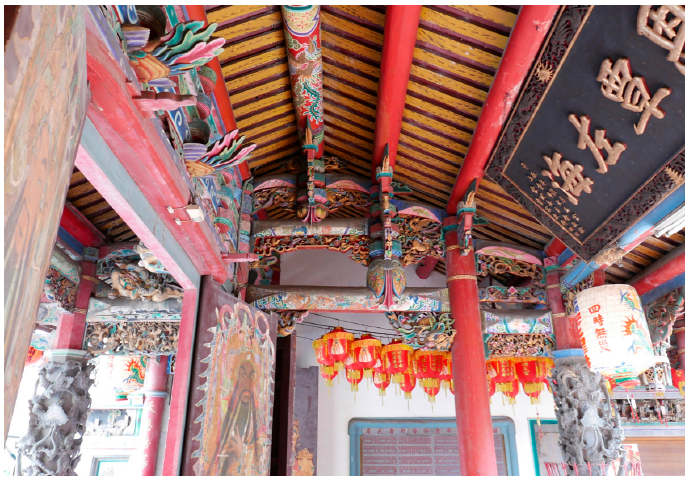
Figure 1. Dieh-Dou timber frame.